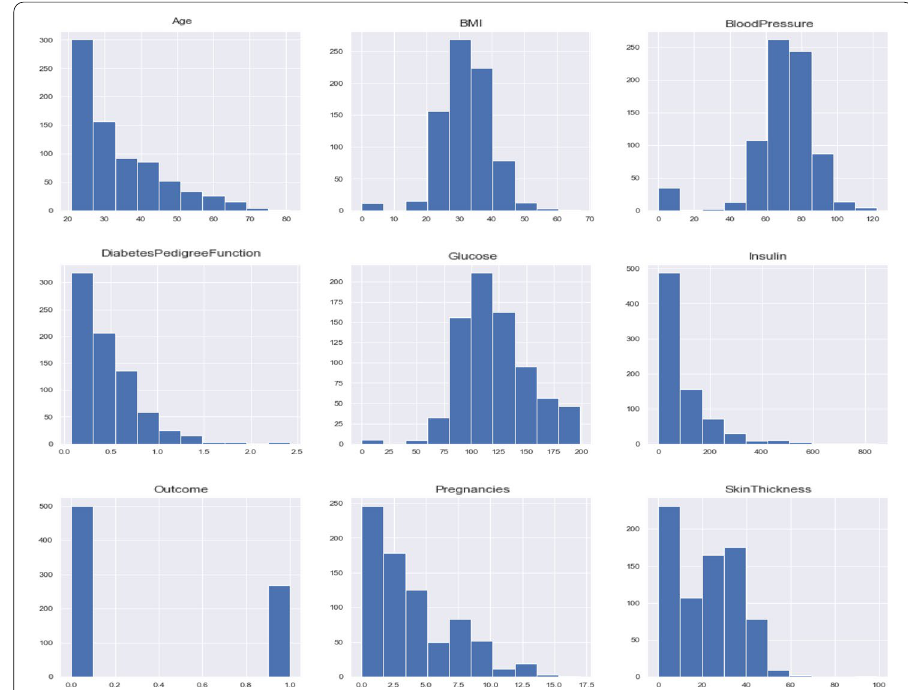
Fig. 9 Mono distribution in terms of each feature (Age, BMI, Blood pressure, Diabetes Pedigree Function, Glucose, Insulin, Outcome, Pregnancies, Skin